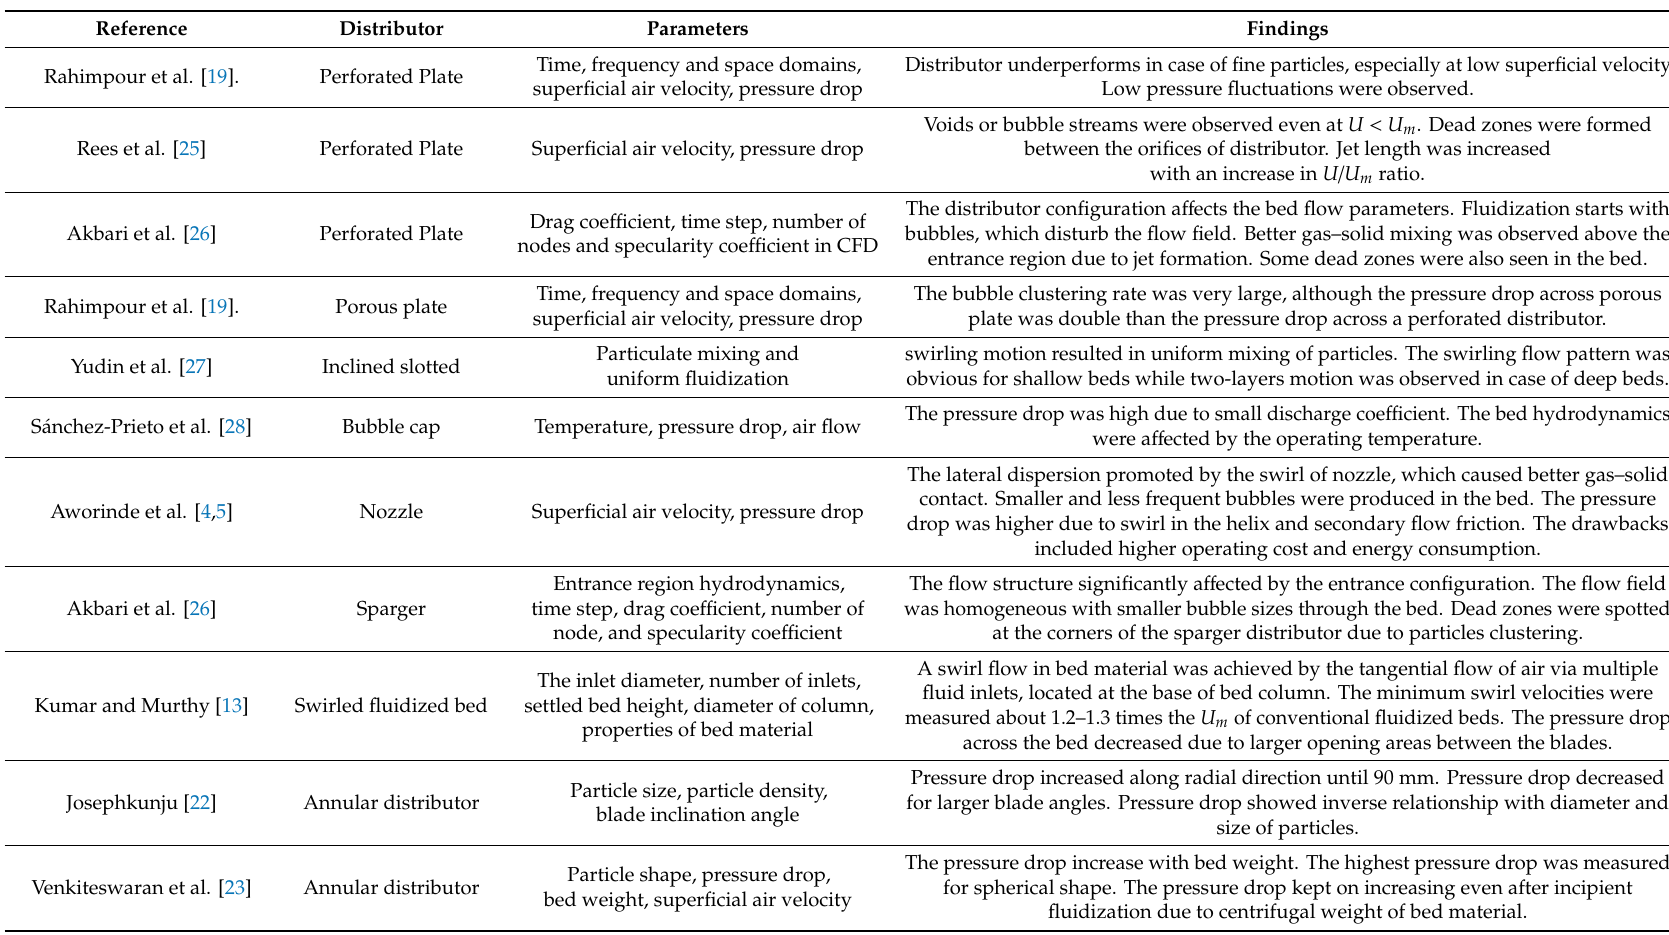
Table 2. A summary of the published literature on annular